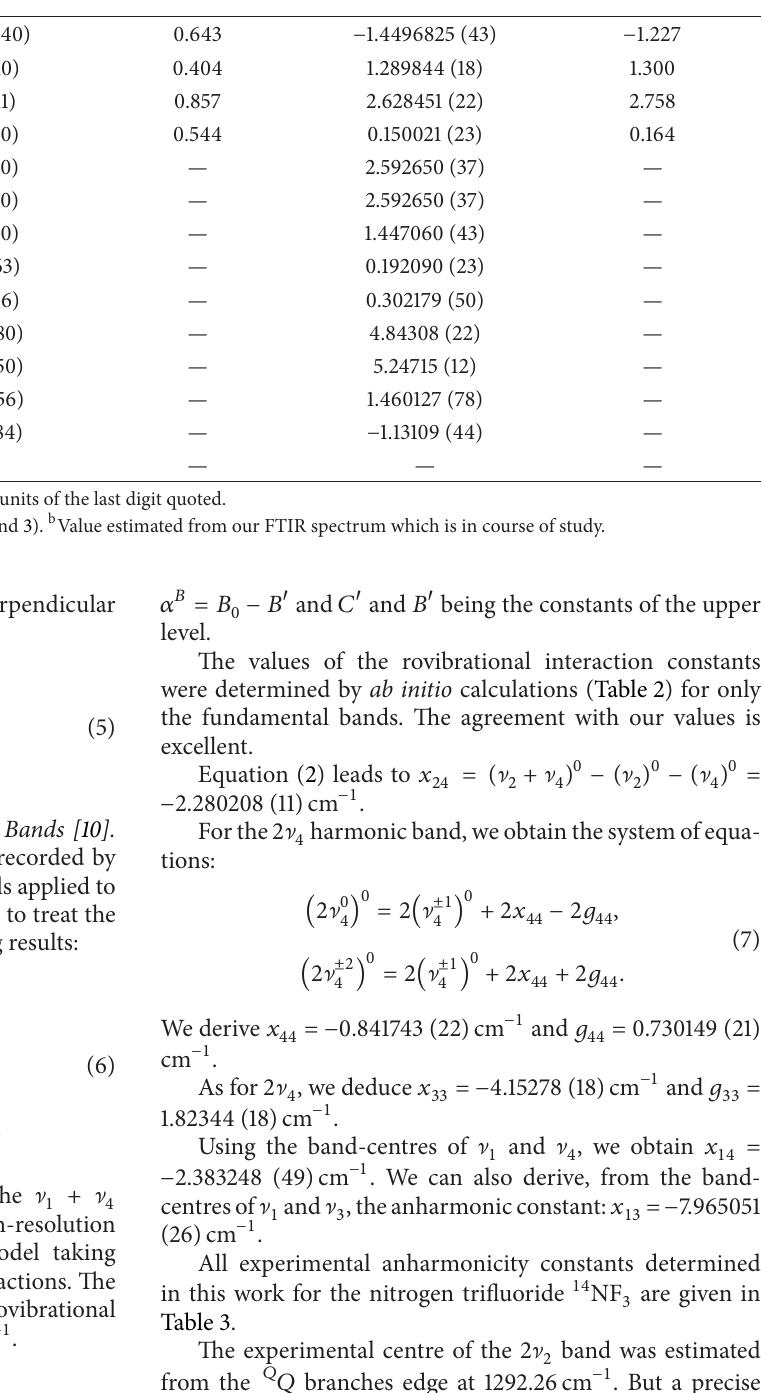
Table 2: Band-centres and rovibrational interaction constants of 14 NF Band